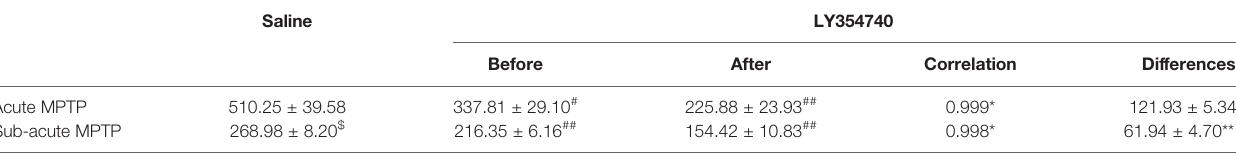
TABLE 1 | Extracellular glutamate determination (pg/ m